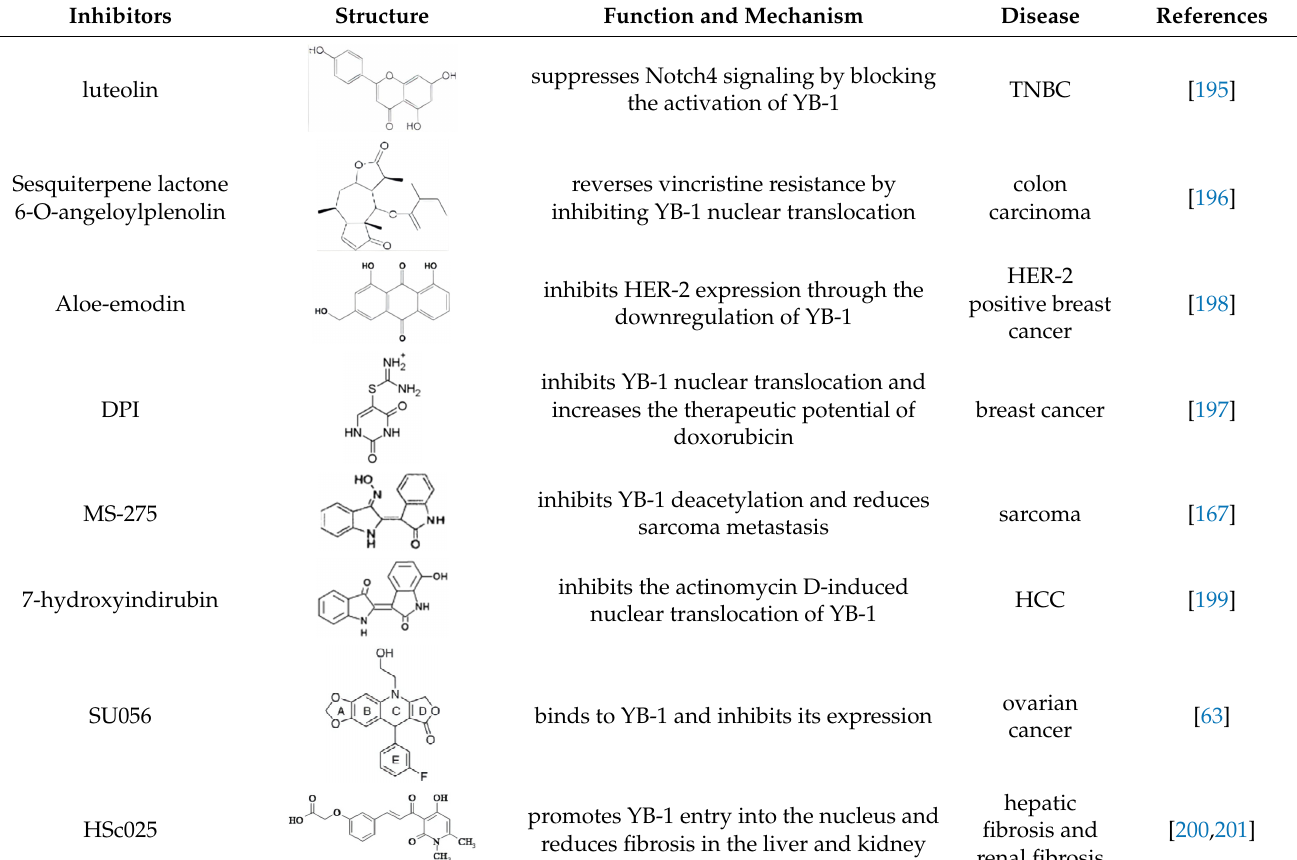
Table 1. Inhibitors of YB-1 pathway.